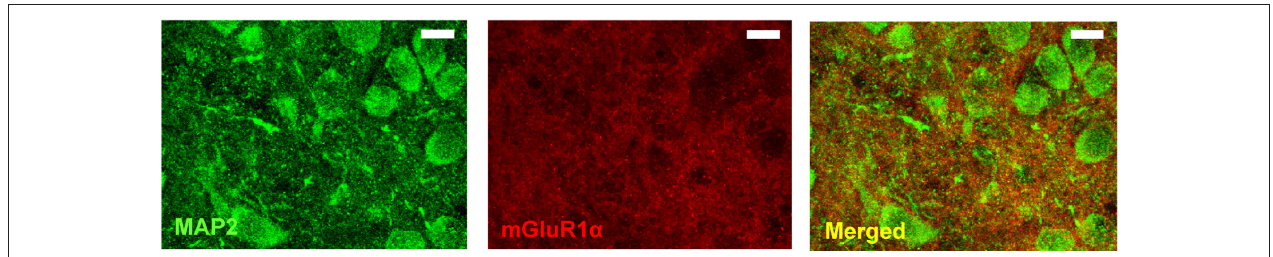
FiGure S1 | immunohistochemical staining of mGlur1 α and MAP2. Neurons of the dLGN were stained using specific antibodies against microtubule associated protein 2 (MAP2) and against mGluR1 α conjugated to Cy2 and Cy3, respectively. While MAP2 was clearly present in the soma, mGluR1 α appears to be absent there. Scale bars indicate 10 μm.